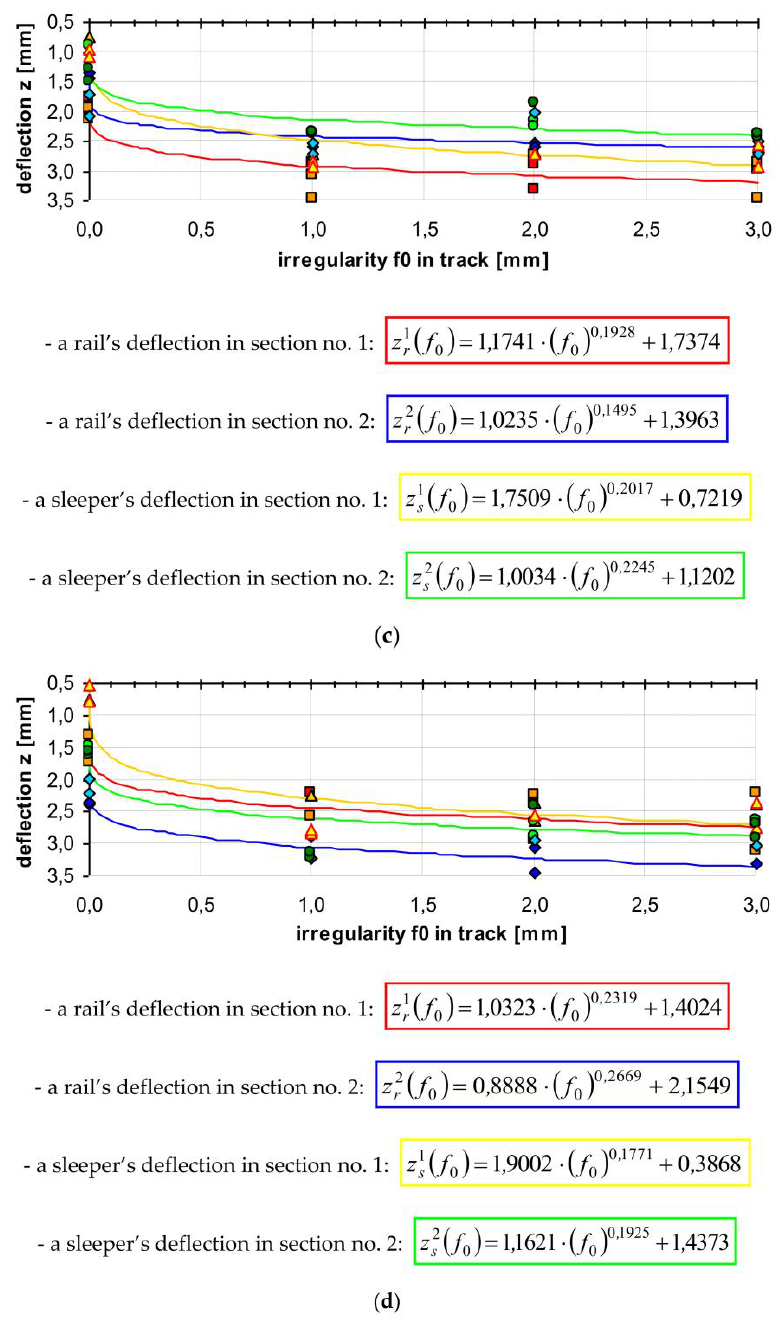
Figure 7. A deflection of the rail and sleeper due to induced irregularity in the railway track (axle load no. 1 and no. 2 of the locomotive): ( a ) axle load no. 1 in section no. 1 – 1 axle (R 2 = 0.819); ( b ) axle load no. 1 in section no. 2 – 1 axle (R 2 = 0.842); ( c ) axle load no. 2 in section no. 1 – 2 axle (R 2 = 0.821); ( d ) axle load no. 2 in section no. 2 – 2 axle (R 2 = 0.896).